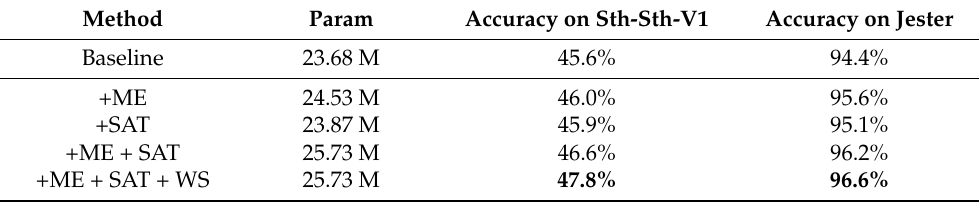
Table 7. Accuracy and model parameters on Something-Something-V1 and Jester data sets.